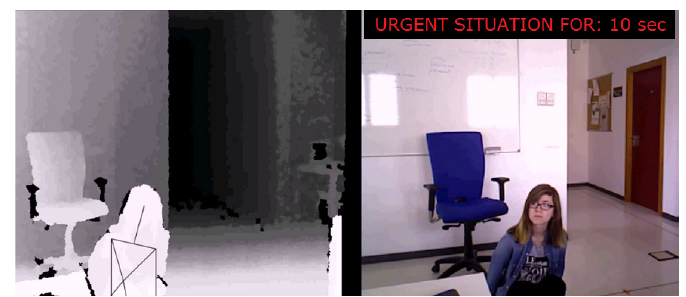
Figure B3. Urgent situation